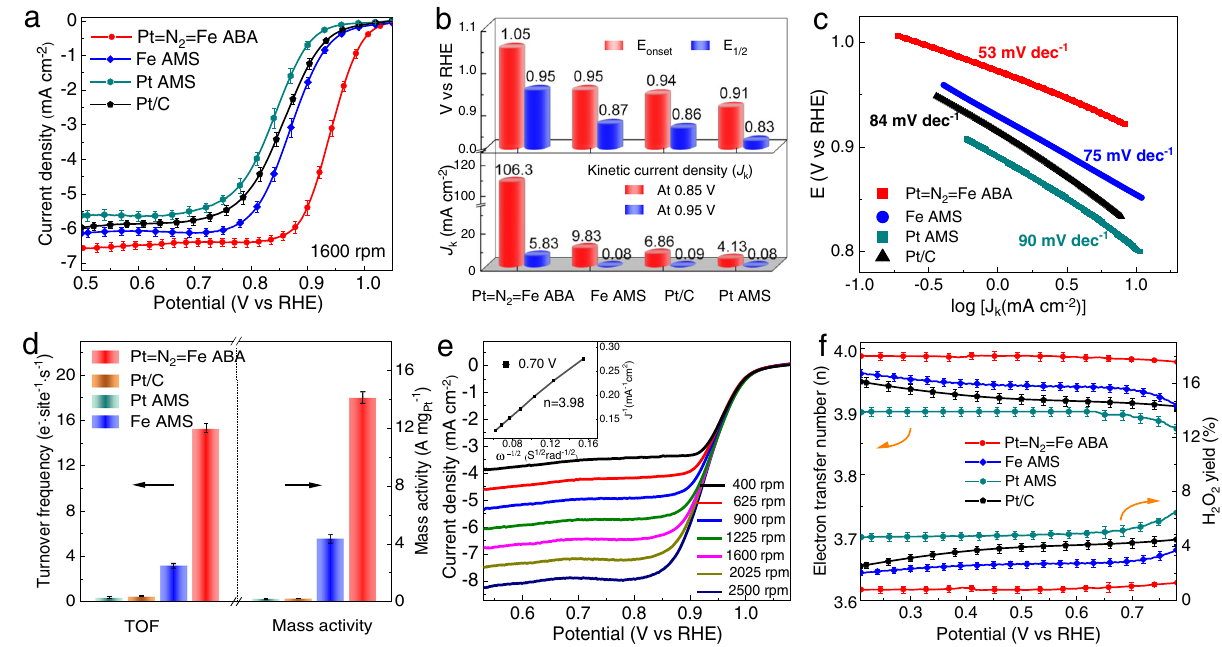
Fig. 2 | Electrochemical oxygen reduction performance measurements. a ORR polarizationplotsofPt=N 2 =FeABA,Pt/C,PtAMSandFeAMS. b Theperformance parametersofhalf-wave potential ( E 1/2 ),onset potential( E onset ) and kinetic current density ( J k ). c Tafel plots, d turnover frequency (TOF) and mass activity for